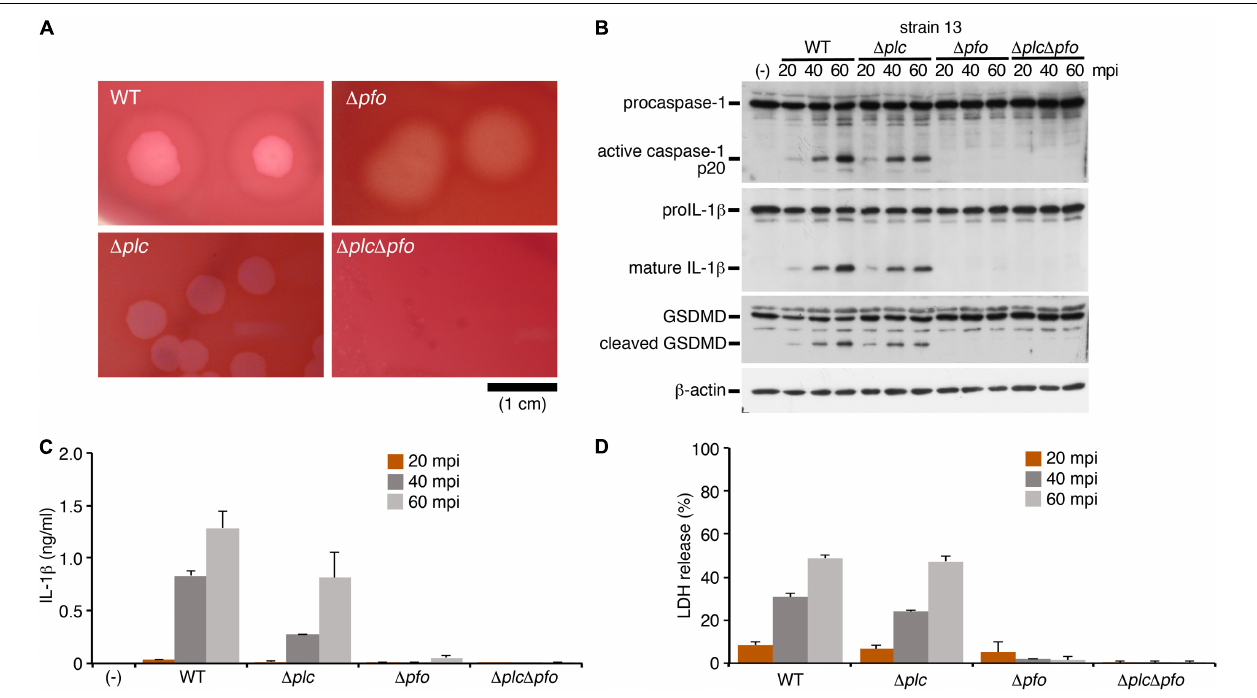
FIGURE 2 | The inflammasome activation induced by Clostridium perfringens is mediated by the pore-forming toxin, perfringolysin O (PFO). BMDMs were primed with LPS for 2 h, and infected with WT C. perfringens (strain 13) and/or any of its isogenic mutants, (cid:49) plc ( α -toxin mutant), (cid:49) pfo (PFO mutant) and (cid:49) plc (cid:49) pfo (double-mutant of α -toxin and PFO). (A) 1.5% (w/v) agar plates containing brain heart infusion (BHI) medium and 5% (v/v) defibrinated sheep blood show different degrees of hemolysis induced by the C. perfringens strains. Bar, 1 cm. (B) Activation of caspase-1, and cleavage of IL-1 β or GSDMD in the infected BMDMs was analyzed by immunoblotting with anti-caspase-1 (p20), anti-IL-1 β and anti-GSDMD antibody, respectively. (C) IL-1 β release from the infected BMDMs into the culture supernatants at 20–60 mpi was analyzed by an ELISA. (D) Culture supernatants from infected BMDMs were analyzed for LDH release at 20–60 mpi. Data are presented as the means ± SD of triplicate